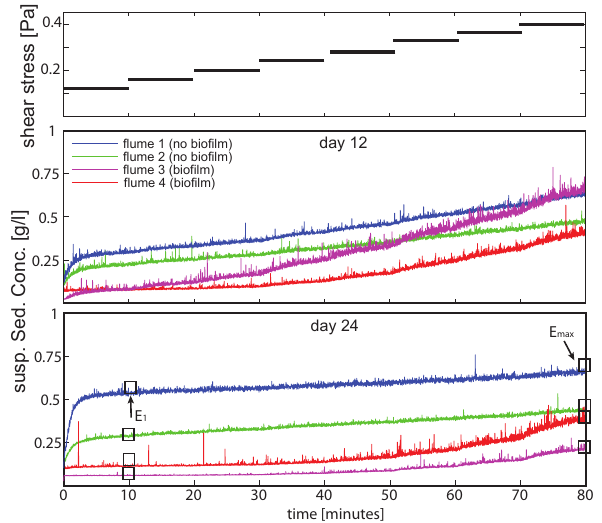
Fig. 2. Example of an erosion experiment. (A) Applied shear stresses. (B, C) Suspended sediment concentration as a function of time, in two different days. The values of E 1 and E max are indicated by